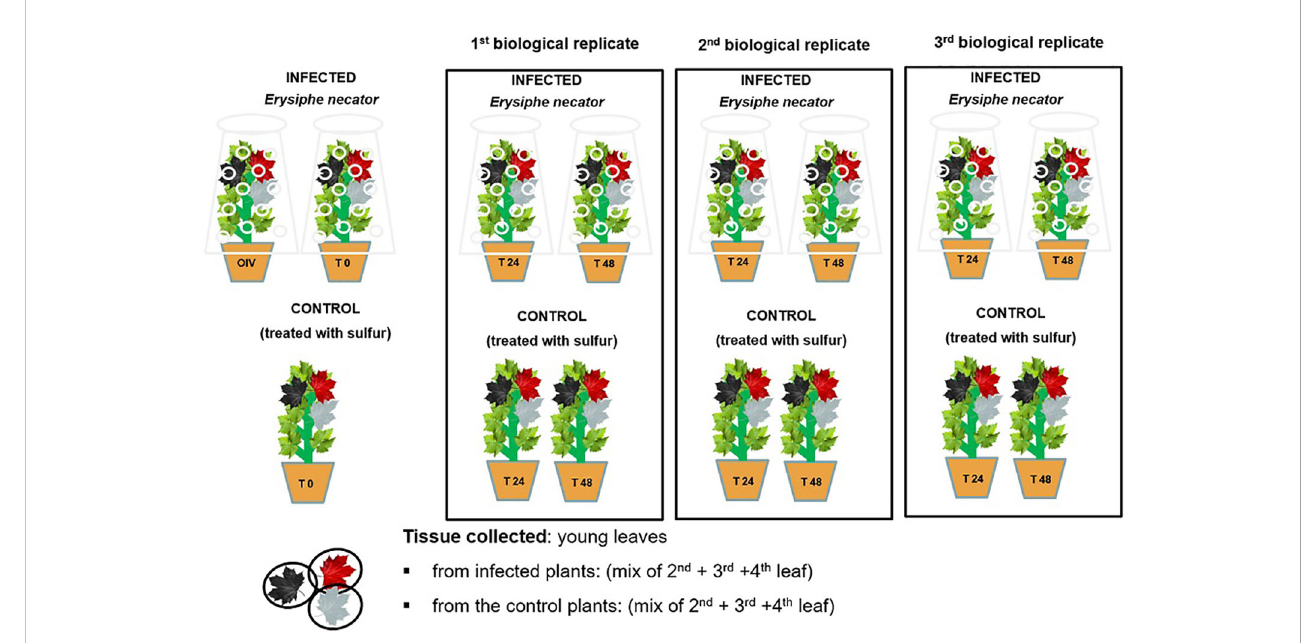
FIGURE 2 A schematic representation of the randomized experimental design of E. necator ’ s